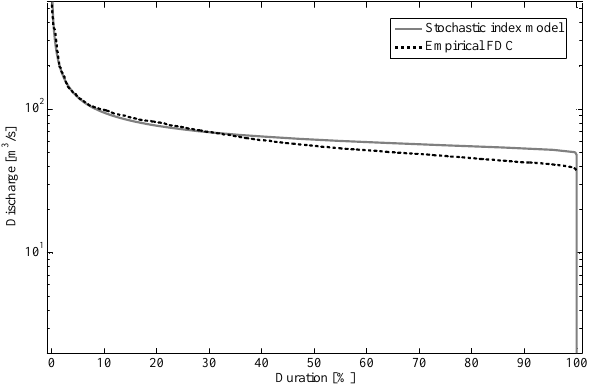
Fig. 9. Results of application of the stochastic index flow model for site n. 8 (semi-logarithmic representation). The broken black line represents the empirical FDC; the grey line represents the FDC obtained with the stochastic index flow model.